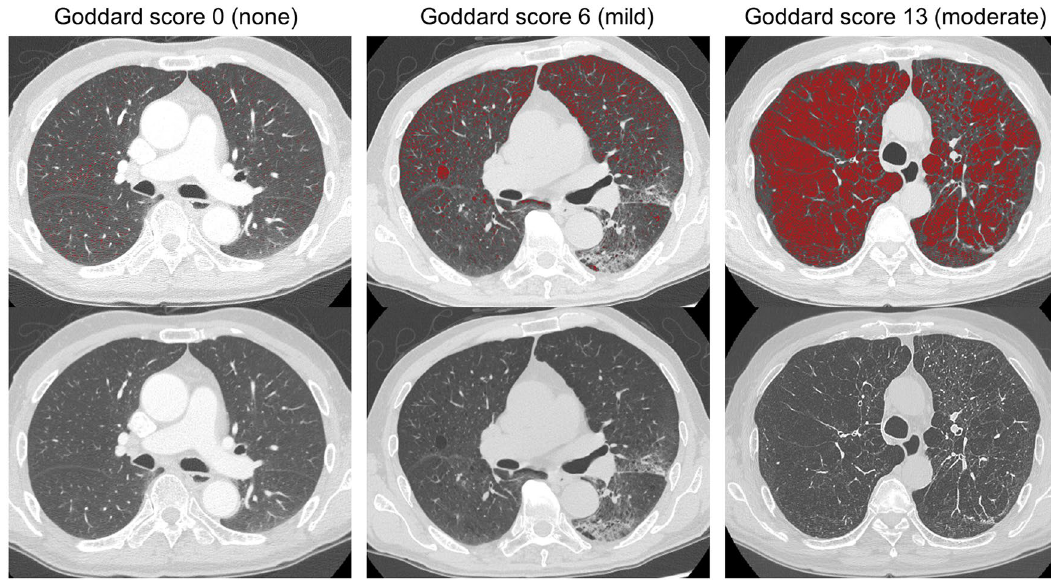
Figure 3. Representative computed tomography images showing the Goddard score using SYNAPSE VINCENT software (Fujifilm Medical, Tokyo,